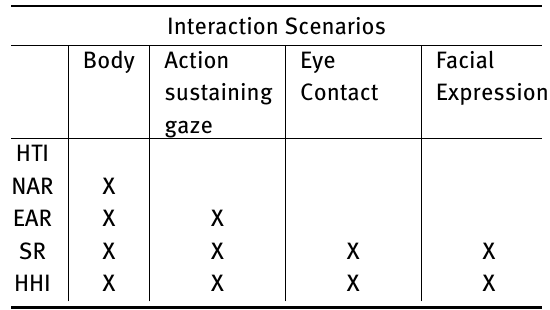
Table 2: Behavioral parameters used for each of the five conditions. The "X" signifies the existence of that